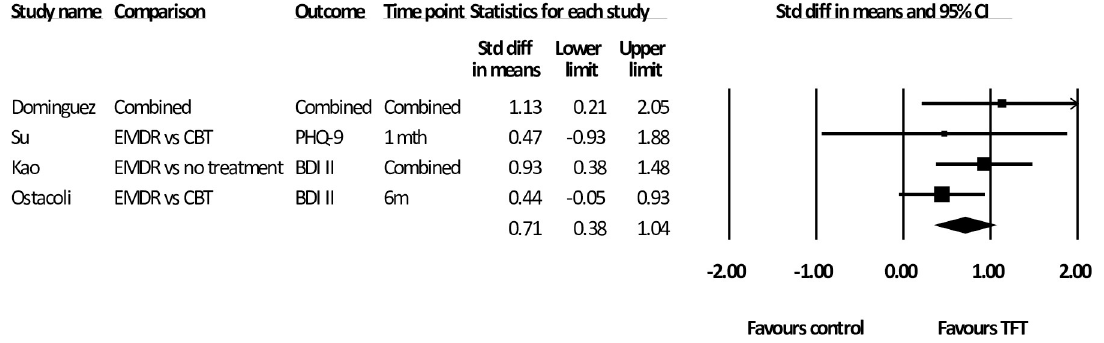
Fig 5. Standardised effect sizes of trauma-focused treatments for depression compared to control conditions at follow-up.